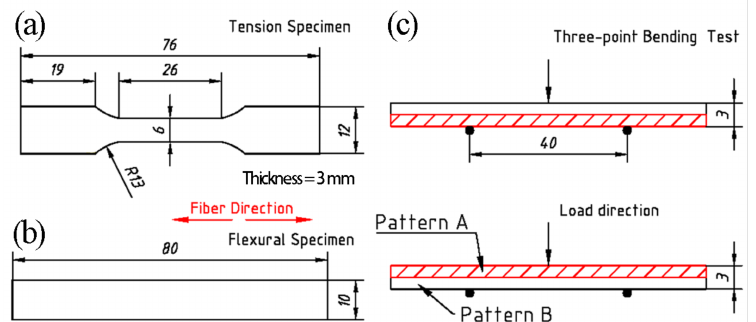
Figure 5. Schematic illustrations of the specimens (units: mm): ( a ) tensile specimen; ( b ) flexural